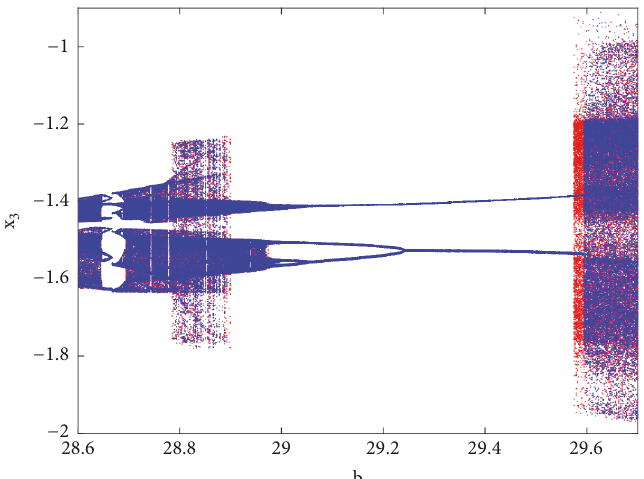
Figure 5: Bifurcation diagram for illustrating the coexistence of disconnected chaotic attractors with a pair of period-2 limit cycle. The diagram is plotted by forward or backward continuation of parameter b with the following initial conditions x 1 (0) = 3; x 2 (0) = x 3 (0) = x 4 (0) = x 5 (0) = 0 and x 1 (0) = 1; x 2 (0) = x 3 (0) = x 4 (0) = x 5 (0) = 0.